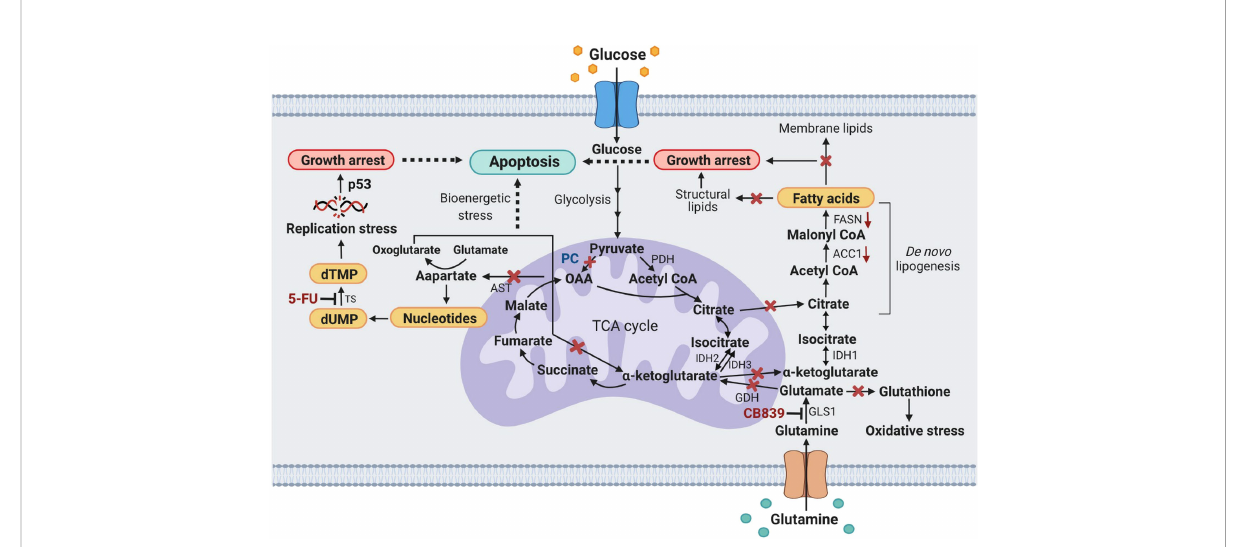
FIGURE 7 A schematic diagram showing metabolic stress-induced apoptosis in PC KO HT29 cells exposed to CB-839 or 5-FU. X, inhibition or perturbation of pathway; ( ↓ ) down-regulation. ACC1, acetyl-CoA carboxylase 1; AST, aspartate aminotransferase; dTMP, deoxythymidine monophosphate; dUMP, deoxyuridine monophosphate; FASN, fatty acid synthase; GDH, glutamate dehydrogenase; GLS1, glutaminase 1; IDH1, 2, 3, isocitrate dehydrogenase 1, 2, 3; OAA, oxaloacetate; PC, pyruvate carboxylase; p53, tumor protein 53; PDH, pyruvate dehydrogenase; TS, thymidylate